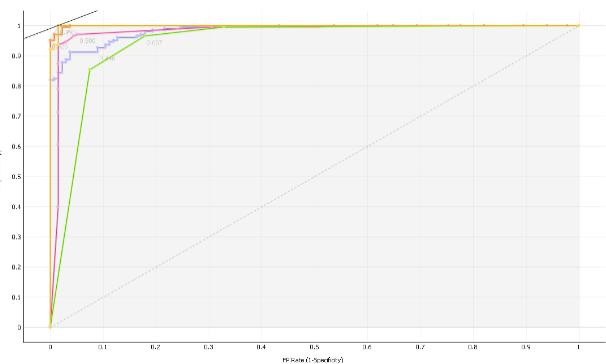
Fig. D1. ROC curve analysis relating to class “Good”